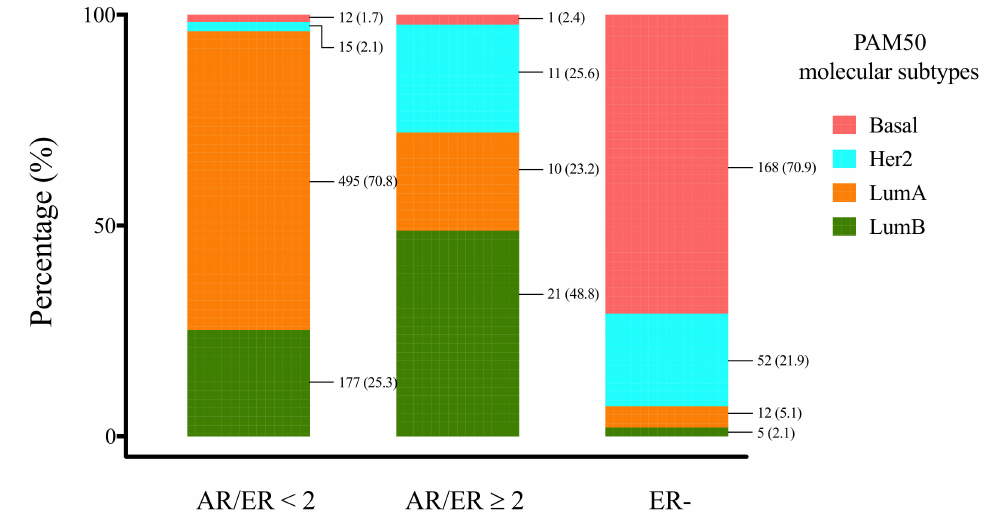
Figure 3. Molecular subtype distribution of BC cases from GDC, grouped by AR / ER ratio. Cases with ratio AR / ER ≥ 2 were distributed significantly di ff erent respect other groups and are mainly represented by luminal B and HER2-enriched tumors. AR / ER ≥ 2 vs. AR / ER < 2: P < 0.00001*. ER − vs. Other groups: P < 0.00001*. Numbers linked to colours in each bar correspond to total number of cases and its percentage, N (%). ER − : estrogen receptor negative cases. * Chi-Square test (X 2